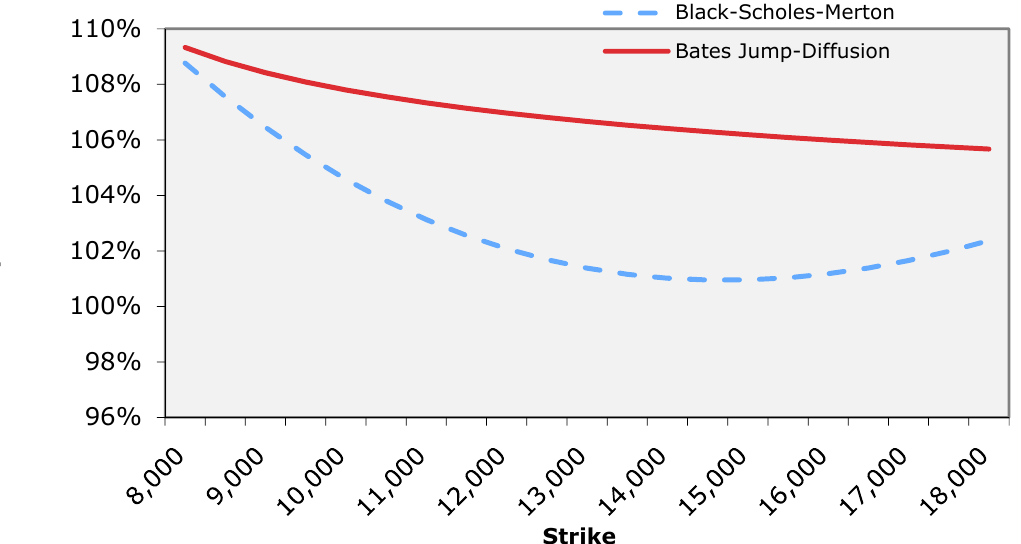
Figure 5. Volatility Smile Fitting . Figure depicts the volatility smile that the parametrization of the implied volatility smile in terms of the strike. This figure plots implied volatilities of call options on the Bitcoin price index as a function of their strikes and maturities for the Bates’ model (red solid line) and the BSM model (blue dotted line). More importantly, the Bates’ volatility jump-diffusion model is consistent with an asymmetric volatility smile. This model assumes jump risk is systematic and appears to be a much closer match to reality than Merton due to the simultaneous asset price jumps and amplitudes, possibly by varying amounts.